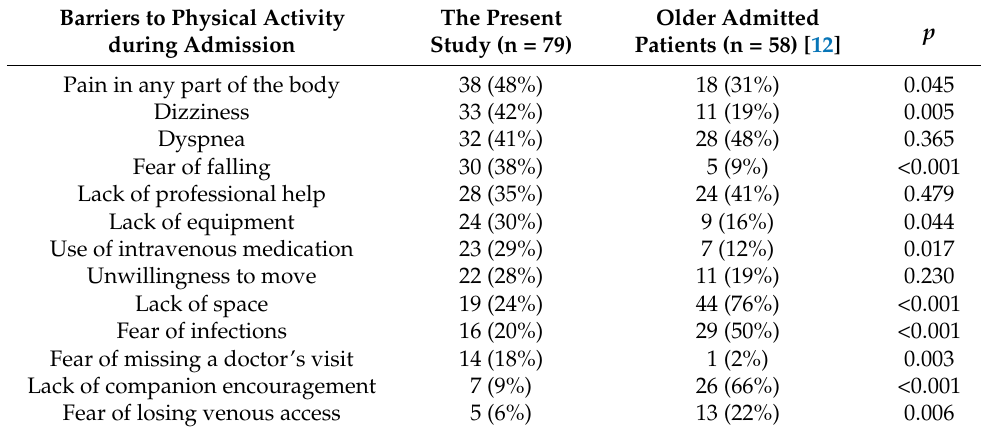
Table 2. Self-reported barriers to physical activity during admission in patients with type 2 diabetes and older patients with other diseases.